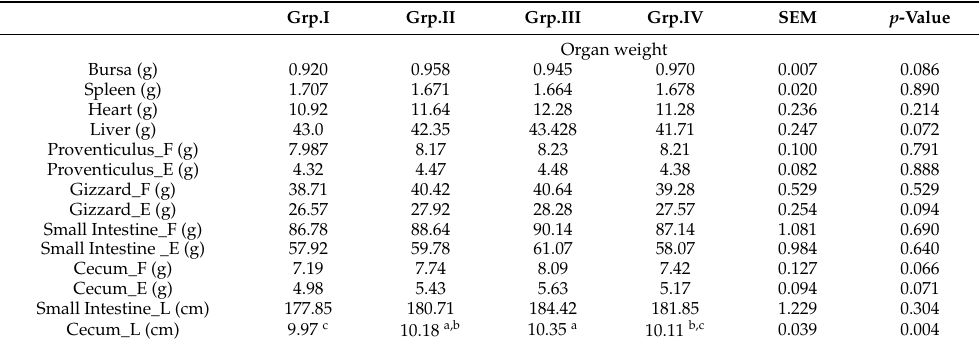
Table 3. Influence of inclusion of the organic acid and phytogen composite on the broiler absolute organ weight (g)/ length